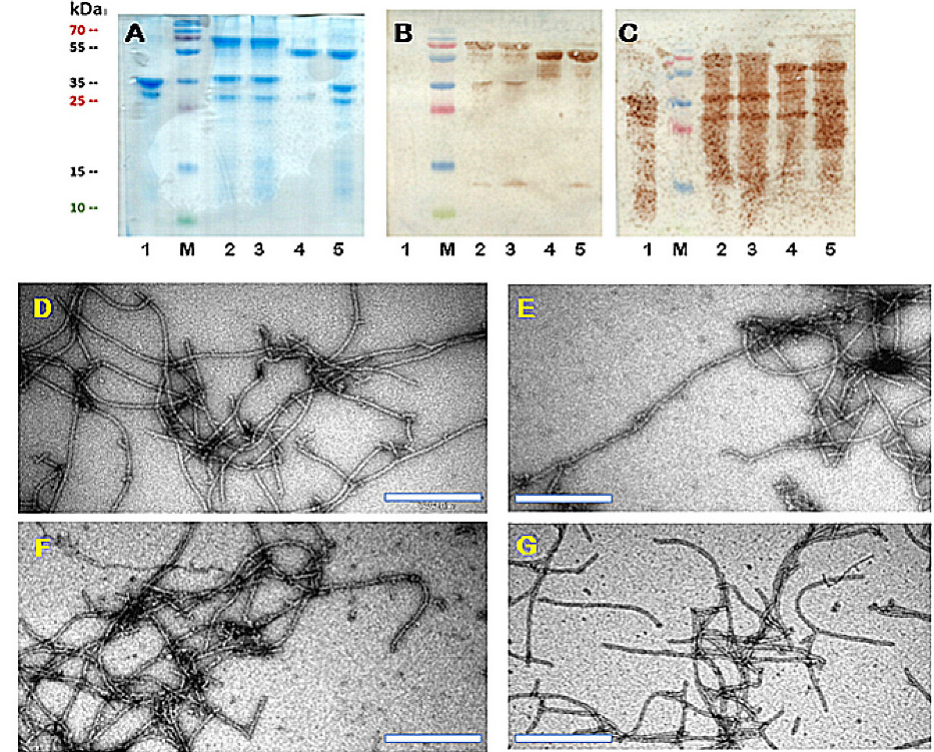
Figure 2. Characterization of PVY CP VLPs with the Fel d 1 antigen. ( A ) Coomassie-stained SDS– PAGE gel of PVY–Fel d 1 vaccine variants at a concentration of 2 mg/mL; ( B ) the same samples as in ( A ) analyzed by Western blot using anti-Fel d 1 antibodies; ( C ) the same samples as ( A ) analyzed by Western blot using anti-PVY antibodies. Electron micrographs of negatively stained VLPs; ( D ) direct fusion of PVY-NG4S-Fel d 1; ( E ) mosaic PVY-NG4S-Fel d 1; ( F ) PVY-SpyT/SpyC2-Fel d 1; ( G ) PVY-SpyT/SpyC3-Fel d 1, scale bars 500 nm. M—PageRulerTM Plus Prestained Protein Ladder, 10 to 250 kDa (Thermo Fisher Scientific, USA), 1—PVY-NG4S-PVY (mosaic; control); 2—PVY-SpyT-SpyC2- Fel d 1; 3—PVY-SpyT-SpyC3-Fel d 1; 4—PVY-NG4S-Fel d 1; 5—PVY-NG4S-Fel d 1